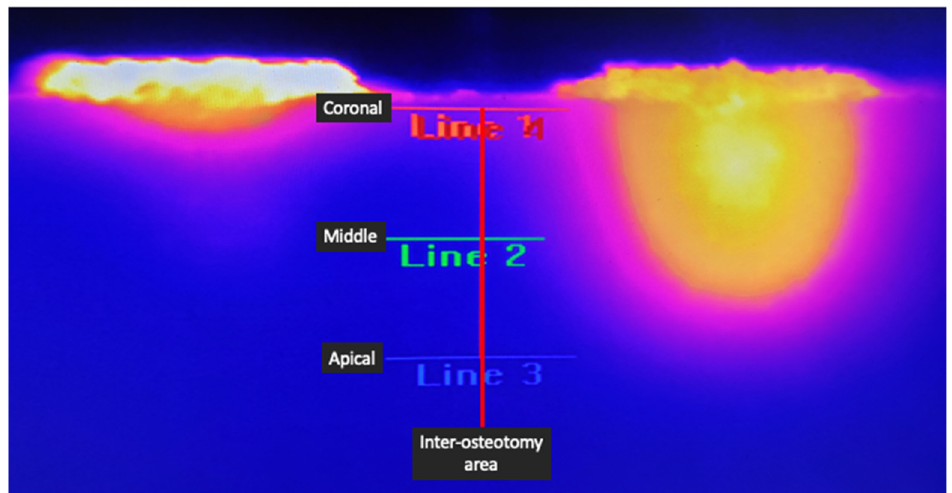
Figure 2. Image demonstrating the setup of measurement recording. The vertical red line in the middle signifies the inter-osteotomy center where the measurements were taken. Lines 1, 2, and 3 indicate the coronal, middle, and apical levels of the inter-osteotomy area, respectively.